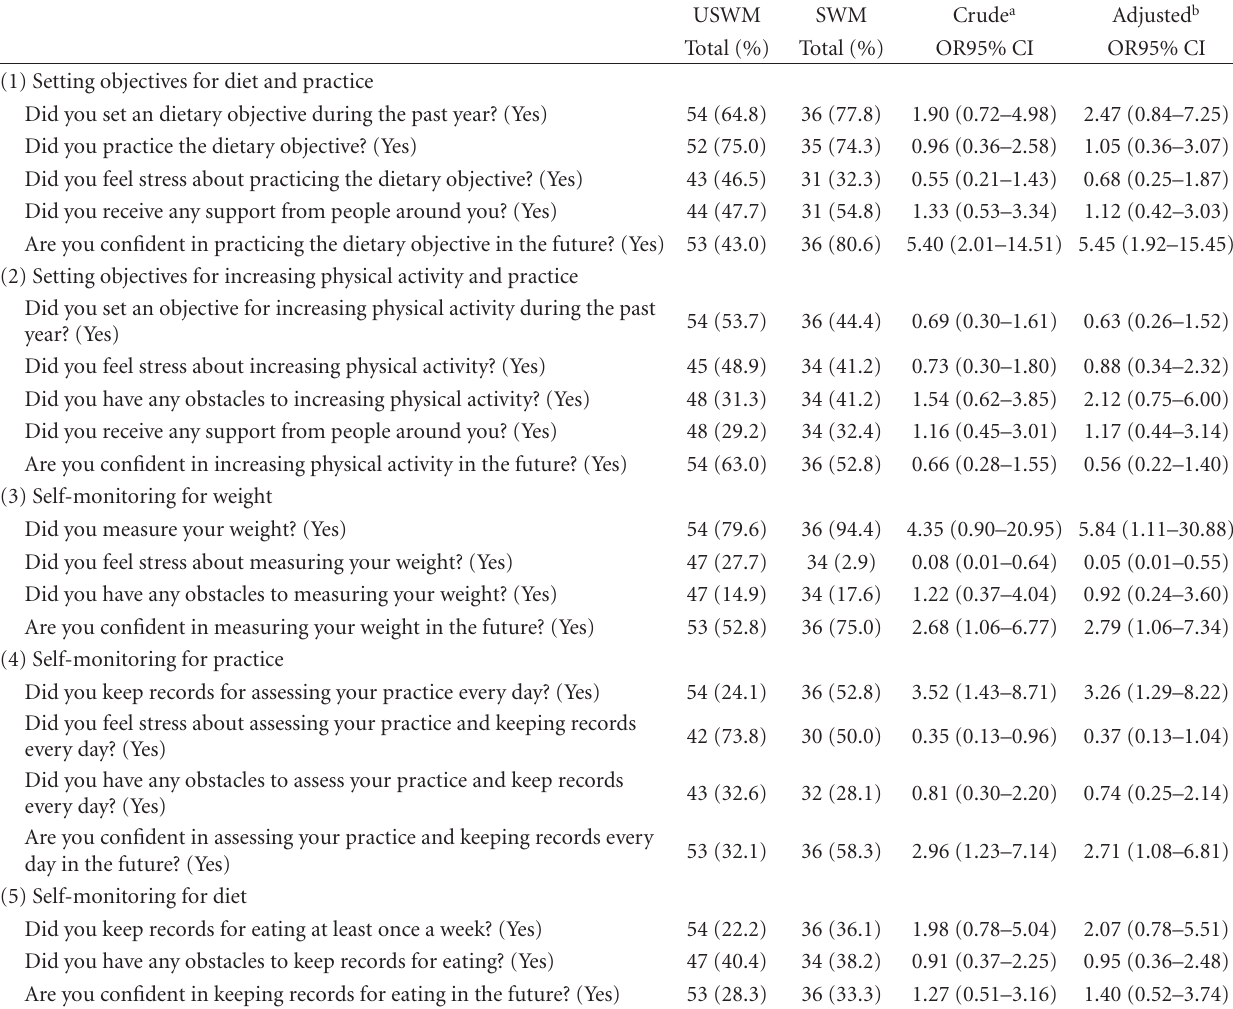
Table 4: Comparisons of participants’ weight control practice, stress, obstacles and support during follow-up period and confidence in the future between successful weight maintainers and unsuccessful weight